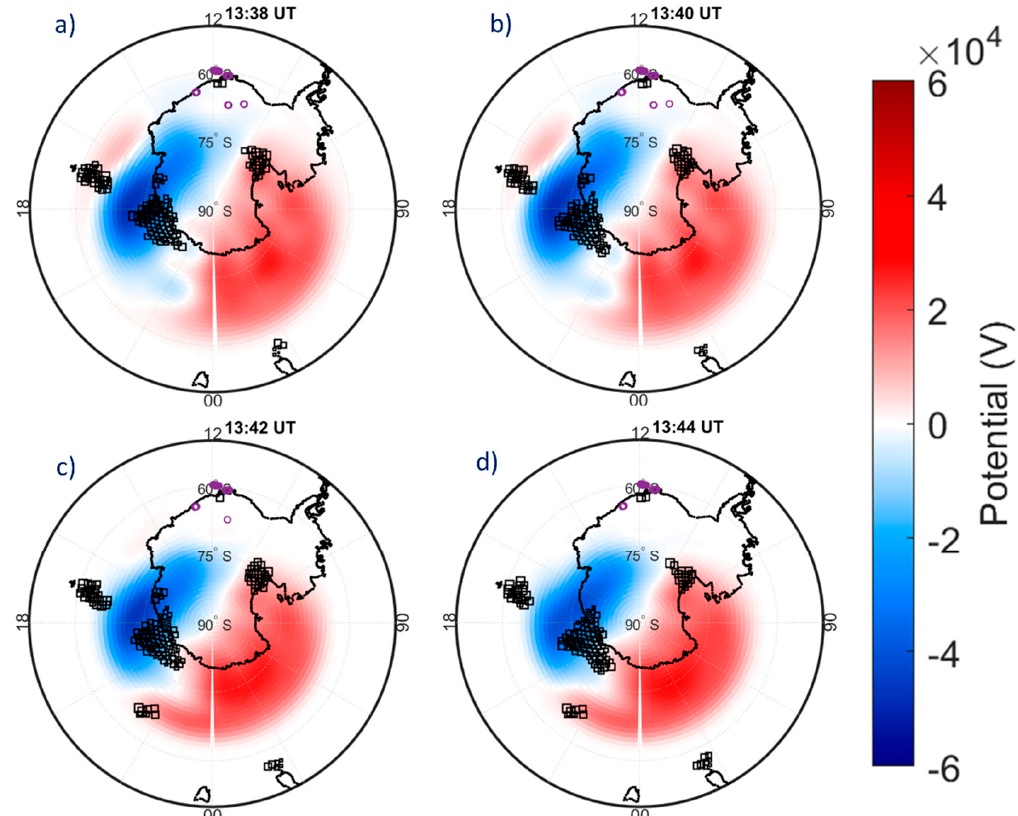
Figure 7. Polar-view maps in AACGM latitude and MLT of SuperDARN observations at 13:38 UT ( a ), 13:40 UT ( b ), 13:42 UT ( c ) and 13:44 UT ( d ) on 8 September 2017. Each map shows the isocontours of the ionospheric potential (red=positive, blue=negative potential) and SuperDARN measurements (black squares) recorded in the two minutes following the time shown at the top of each map. In each map the projection to 350 km of altitude of all the σ ϕ values recorded by SNA0, with elevation angle α = 30 ◦ (purple circles), in the same time interval as for SuperDARN observations are also shown. In each map, which covers 00:00–24:00 MLT and |50 ◦ |–|90 ◦ | AACGM Lat, the magnetic noon/midnight is at the top/bottom.